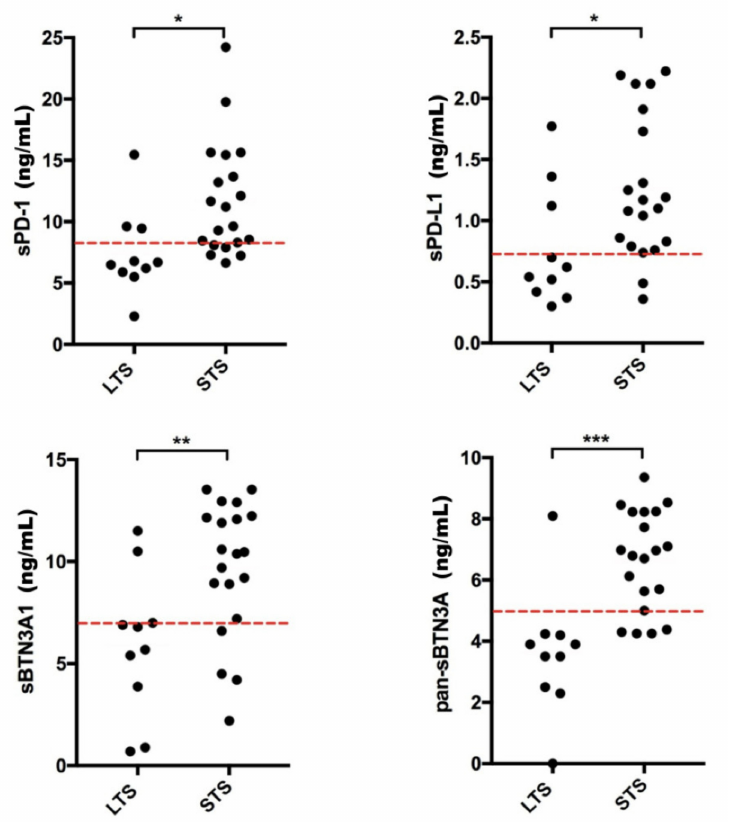
Figure 3. Scatter plot by group discriminating STS and LTS mGIST patients. The plasma concentra- tions of each soluble protein were graphically represented for short-term survival (STS) and long-term survival (LTS) patients. For each circulating immune checkpoint, the red dotted lines point out the best concentration threshold previously determined through ROC analysis. The concentrations are shown in ng/mL. * p < 0.05; ** p = 0.007; *** p =